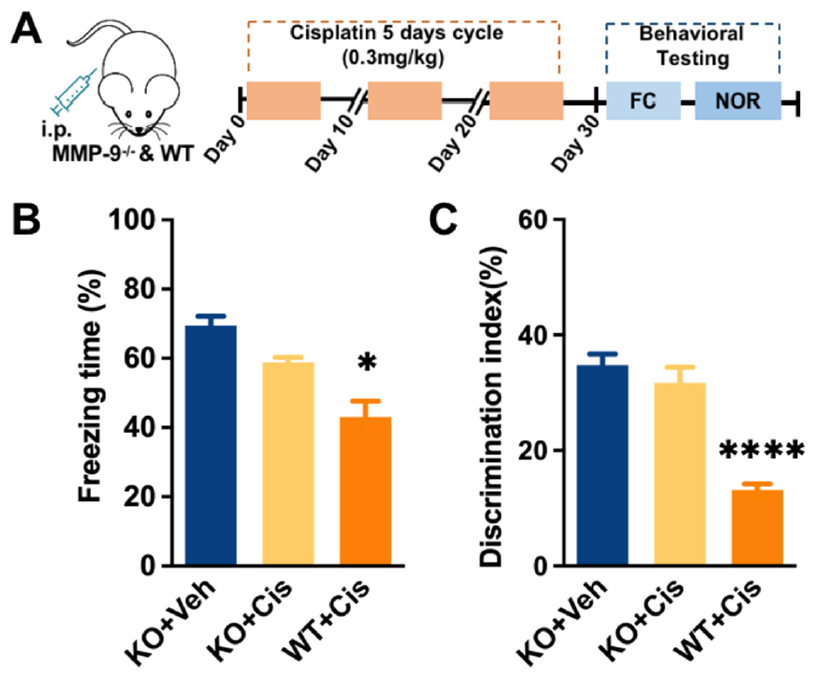
Figure 2. Effects of targeted system mutation of MMP-9 on cisplatin-induced memory impairment. ( A ) Behavior paradigm. ( B ) Effects of targeted mutation of MMP-9 on cisplatin-induced deficiency in freezing behavior. n = 5~8. ( C ) Effects of targeted mutation of MMP-9 on cisplatin-induced